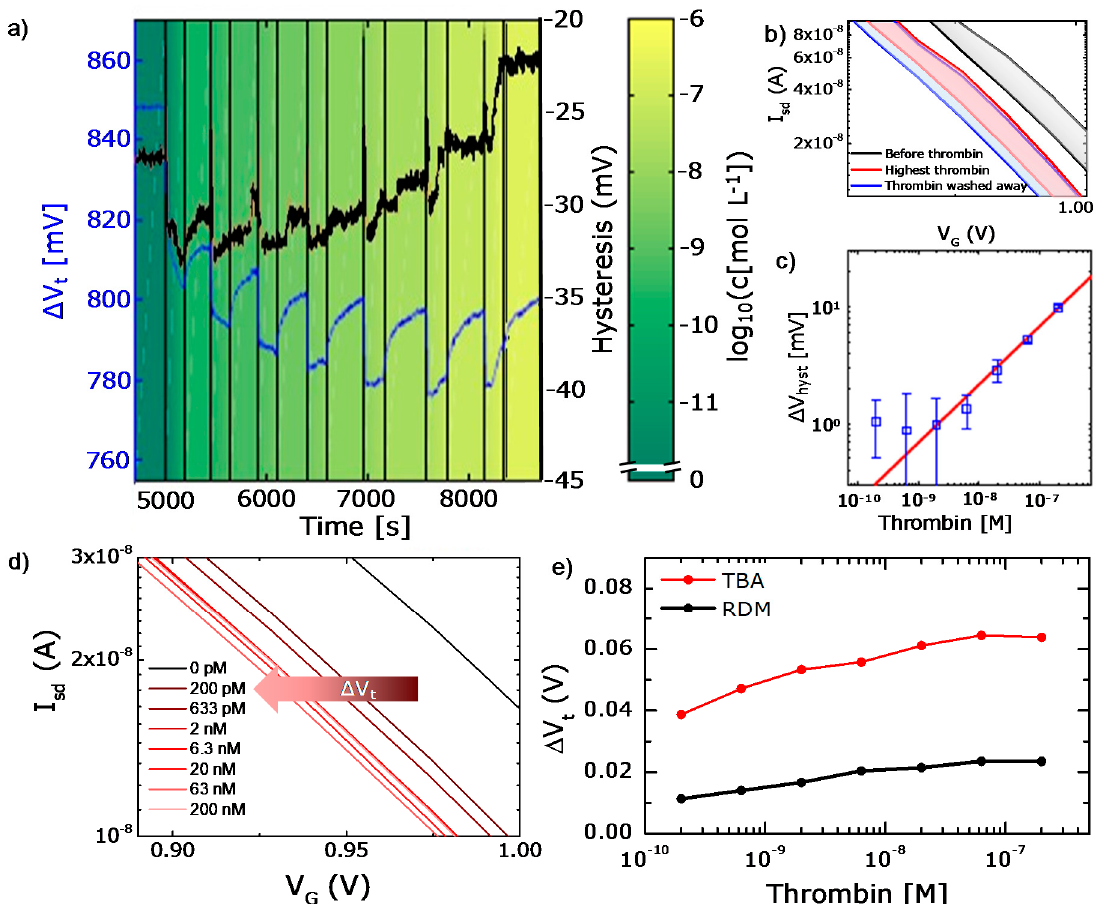
Figure 3. Thrombin detection experiment with the bio-functionalized FET. ( a ) Real-time results upon step by step addition of thrombin, resulting in threshold voltage hysteresis (black line) and threshold voltage shift (blue line). ( b ) Example hysteretic transfer curves before thrombin addition, after thrombin injection and after rinsing. ( c ) Calibration of the hysteresis in the logarithmic scale of thrombin concentration. ( d ) Magnification of the transfer curves after different thrombin concentrations demonstrating an accumulative negative shift. ( e ) Calibration curve of the threshold voltage shift for thrombin detection using the TBA (red line) and the RDM (black line).